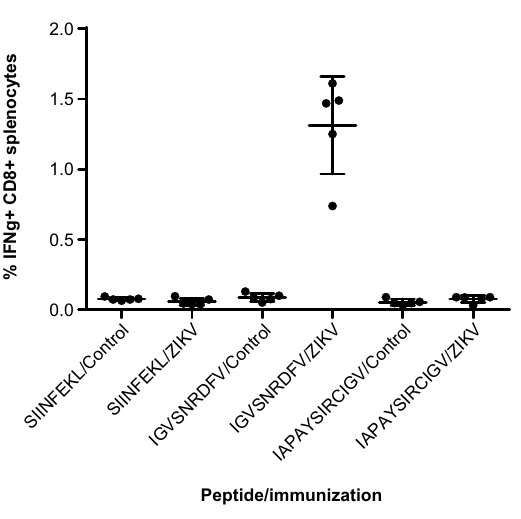
Figure 2. RMA-S cell peptide-binding assay. The binding of the indicated peptides to MHC class I molecules was determined by surface stabilization of H-2Kb or H-2Db molecules on RMA-S cells as measured by flow cytometry. Assays were performed in triplicate. The “ − ” denotes that no peptide was added, and the “ + ” denotes the addition of a peptide known to bind to the measured MHC class I molecule (OVA SIINFEKL for H-2K b , and HPV16 E7 RAHYNIVTF for H-2D b ). Fluorescence intensities were normalized to the no peptide control and data are shown as the means ± SD. ns , not statistically significant from the no-peptide control value according to an unpaired two-tailed t-test ( p > 0.05).